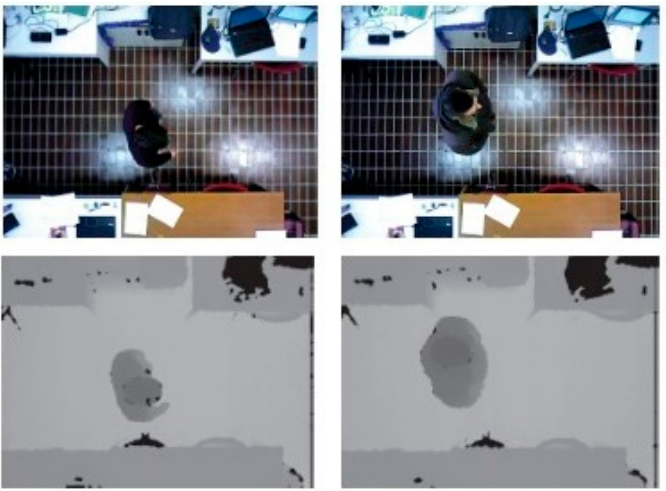
Figure 13. Sample image taken from the TVPR dataset showing an overhead view of a person.